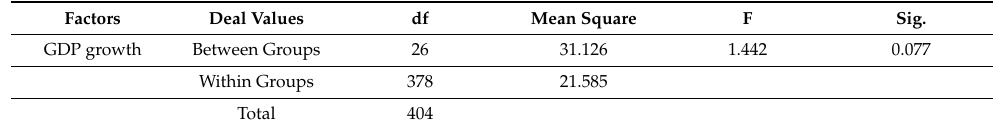
Table 3. ANOVA analysis results for the economic growth.